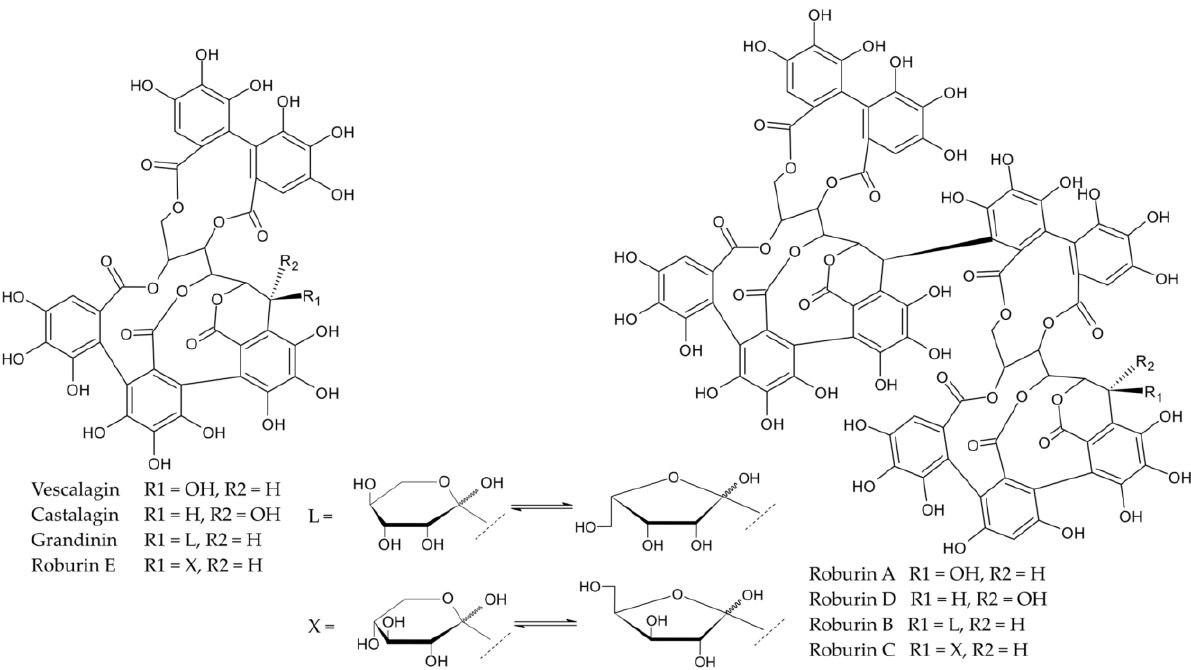
Figure 1. Chemical structures of the eight C-glucosylated ellagitannins. L — Lyxose, X — Xylose [24]. Carpena et al. [4] believe that from a sensory point of view, the most important compounds found in wood are lactones, mainly the cis and trans forms of β -methyl- γ - octolactone, which are responsible for the aromas of coconut and wood. Lactones have a significant sensory effect on alcohols matured with wood, e.g., brandy and whisky; hence, they are often called whisky lactones [4]. The research of Ghadiriasli et al. [12] shows that oak wood is also a source of other lactones, including γ -octolactones, γ - and δ -nonalactones, and γ -decalactones with a peach scent. Table 1 summarizes the compounds derived from wood that have the greatest impact on the sensory properties of alcoholic beverages. Table 1. Main aroma compounds derived from wood [2,5,25 – 33].